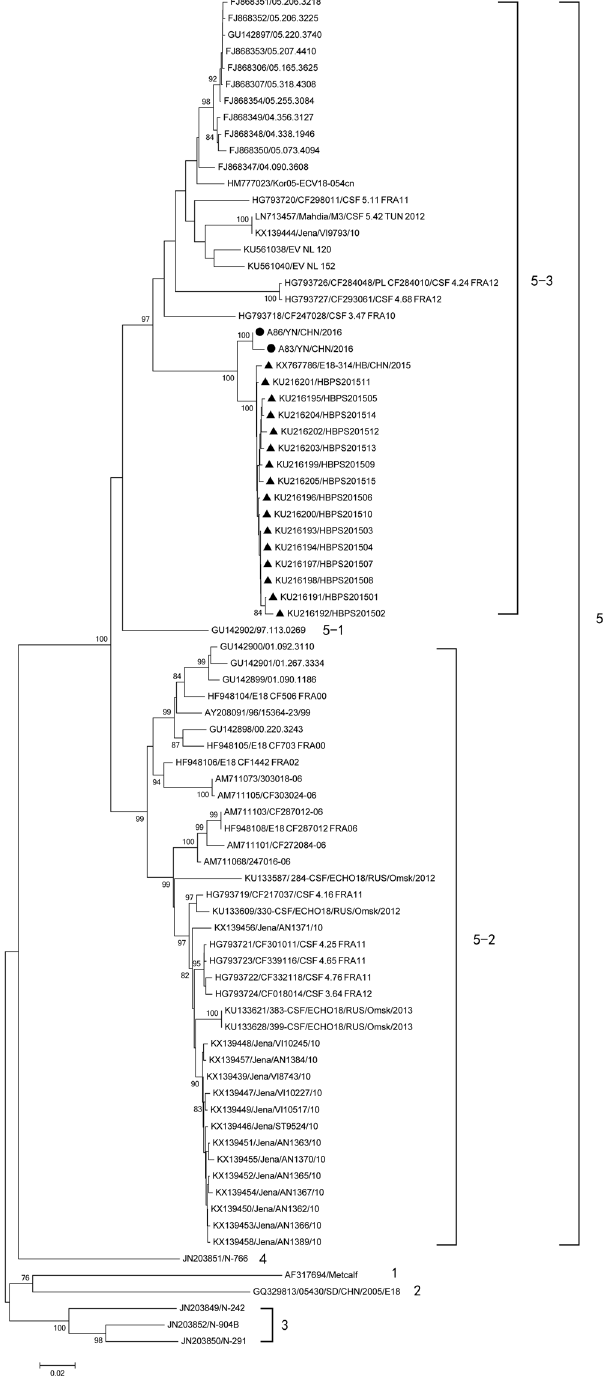
Figure 1. Phylogenetic relationships based on the complete VP1 sequences of 82 E-18 strains. Two Yunnan E-18 strains and the other 80 E-18 strains available in GenBank database were analysed by nucleotide sequence alignment using the neighbor joining algorithms implemented in the MEGA 6.06 program. Numbers at the nodes indicate bootstrap support for that node (percentage of 1000 bootstrap replicates). The scale bars represent the genetic distance. Only high bootstrap values ( > 75%) are shown. • Strains isolated in this investigation. ▲ Strains isolated from other provinces of